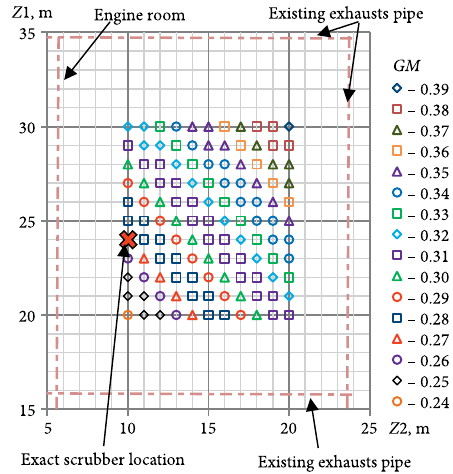
Fig. 12. The deviation of metacentric height depending on the displacement of block 1 and 2 on Z axis